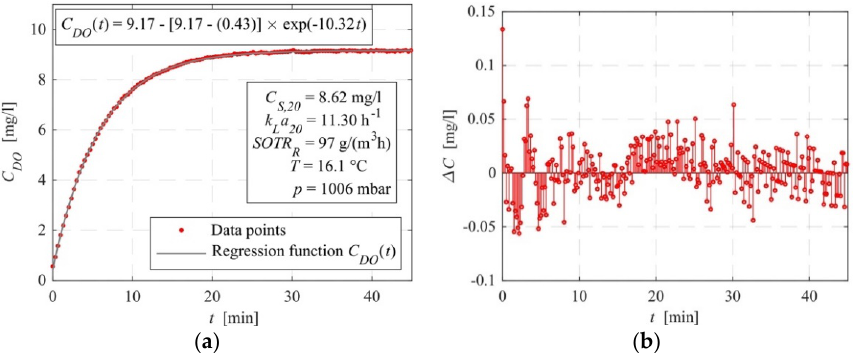
Figure 3. Exponential regression of oxygenation curves for one exemplary model run with 1:2 slope, s = 6 cm and q = 0.11 m 2 /s: ( a ) Fitting to the experimental data for local conditions and resulting standardized oxygen transfer parameters (note: only every 2nd data point is shown for better legibility); ( b ) Residuals resulting from the curve fitting.